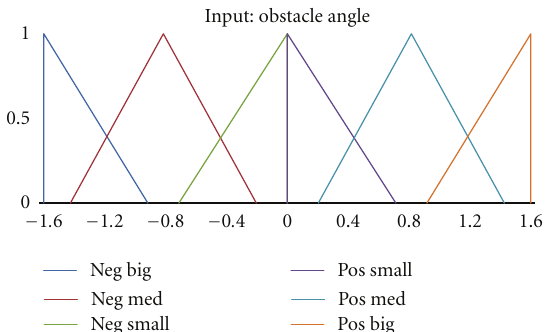
Figure 7: Input: angle between target and agent heading